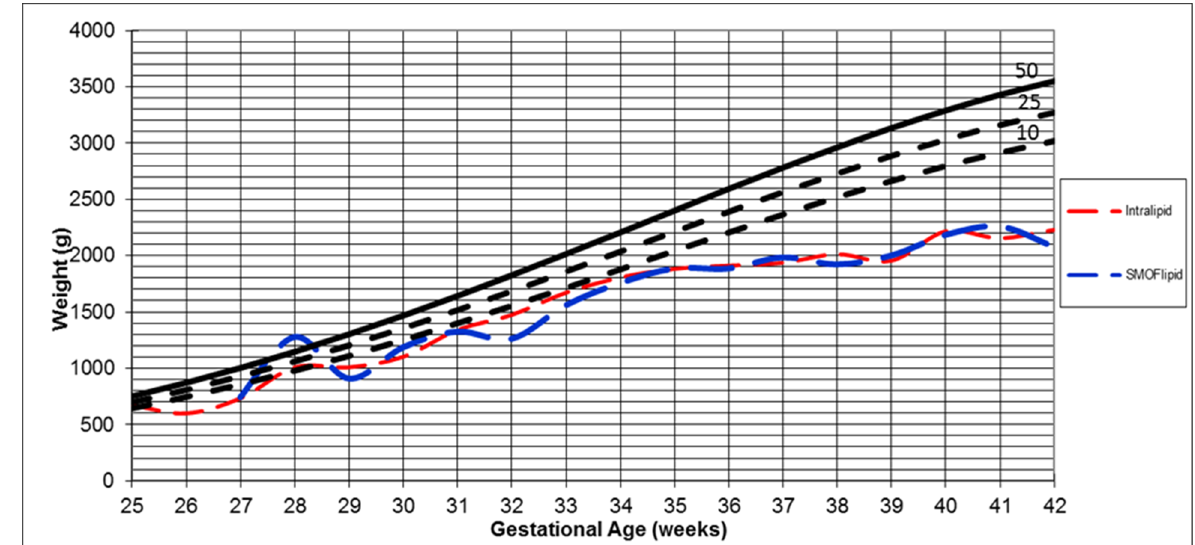
Figure 2. Growth of preterm infants who received SMOFlipid vs. intralipid. The red dash indicates the relationship between the average weight and gestational age among infants who received in- tralipid. The blue dash indicates the relationship between the average weight and gestational age among infants who received SMOFlipid. Table 3. Univariate analysis of growth anthropometrics, neonatal morbidity, and mortality strati- fied by type of LE.